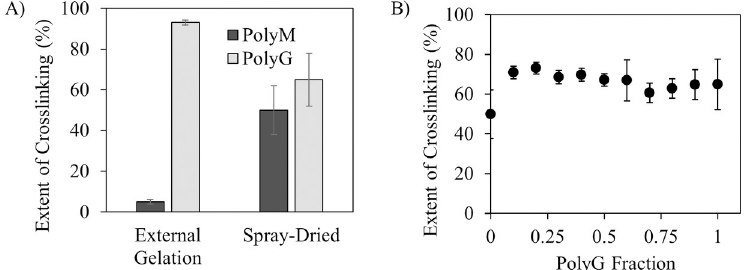
Fig 4. Crosslinking as a function of polyguluronate (PolyG) fraction. A) Crosslinking of external gelation formed and spray-dried powders with 100% PolyM or 100% PolyG (n = 3); B) Crosslinking of spray dried CLAMs formed with ratios ranging from PolyG fraction of 0 (0:1 PolyG to PolyM) to 1 (1: 0 PolyG to PolyM). The difference in crosslinking between PolyG = 0 (100% PolyM) and PolyG = 1 (100% PolyG) cross-linking was not found to be statistically significant (p-value =